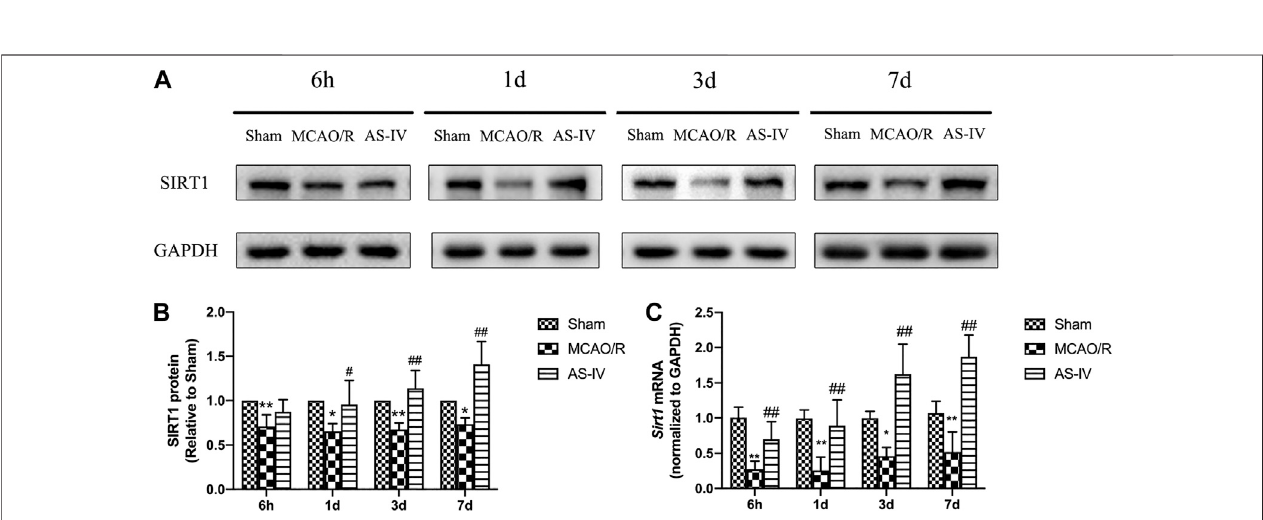
FIGURE4| TheexpressionofSIRT1inShamgroup,MCAO/Rgroup,andAS-IVgroupat6h,1d,3d,and7daysafterCIRinjury(mean ± SD, n (cid:1) 6). (A) Theresults from the Western Blot. (B) Quantitative analysis for the protein level of SIRT1. (C) Quantitative analysis for the mRNA level of Sirt1. * p < 0.05, ** p < 0.01, compared with the Sham group; # p < 0.05, ## p < 0.01, compared with the MCAO/R group.